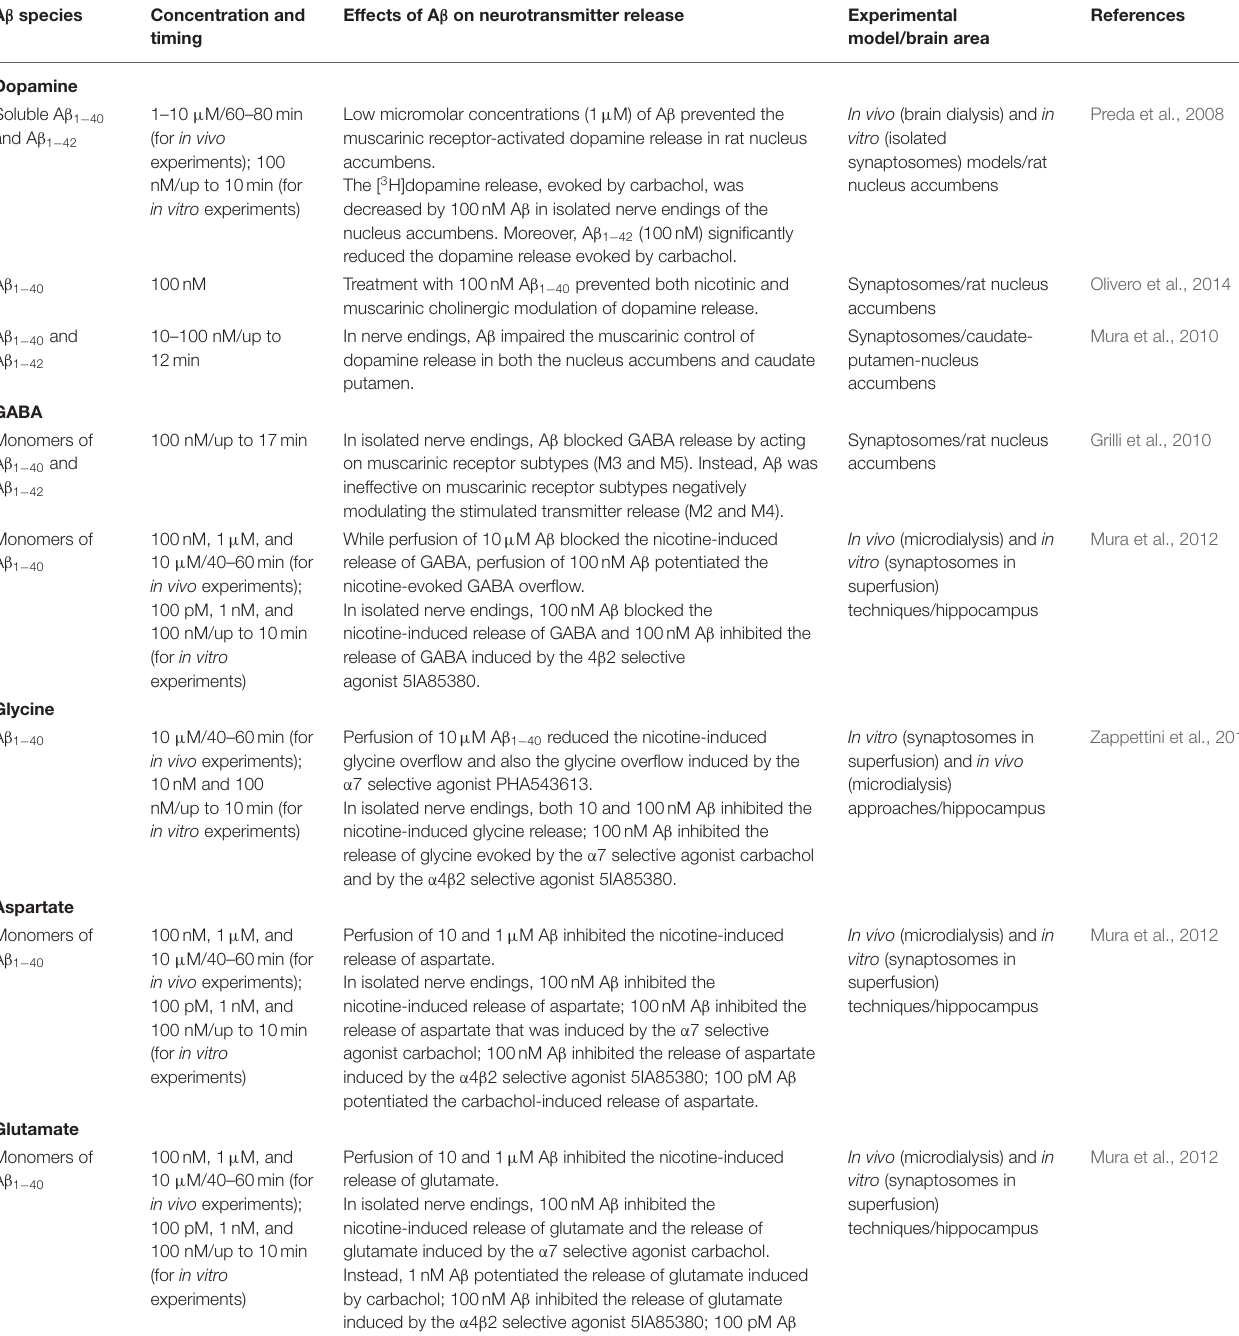
TABLE 1 | Regulation by A β of cholinergic control of neurotransmitter